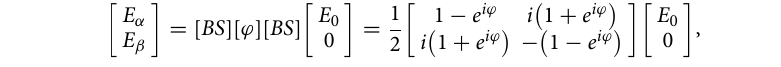
Figure 1. A schematic of unfolded USCKD for ( a ) unfolded and ( b ) folded configurations. Aj( ψ j ) and Bj( ϕ j ) represent an acousto-optic modulator j for Alice and Bob with phase basis ψ respectively, where ψ paths by Eve. LD: Laser, I: isolator, BS: unpolarizing beam splitter, M: mirror, and Dj: detector j. All Aj’s are synchronized via microwave generators at 80